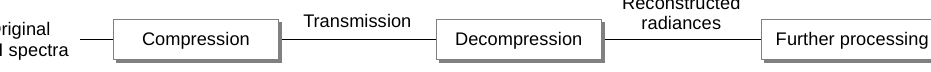
Figure 5. Sequential approach for IASI data